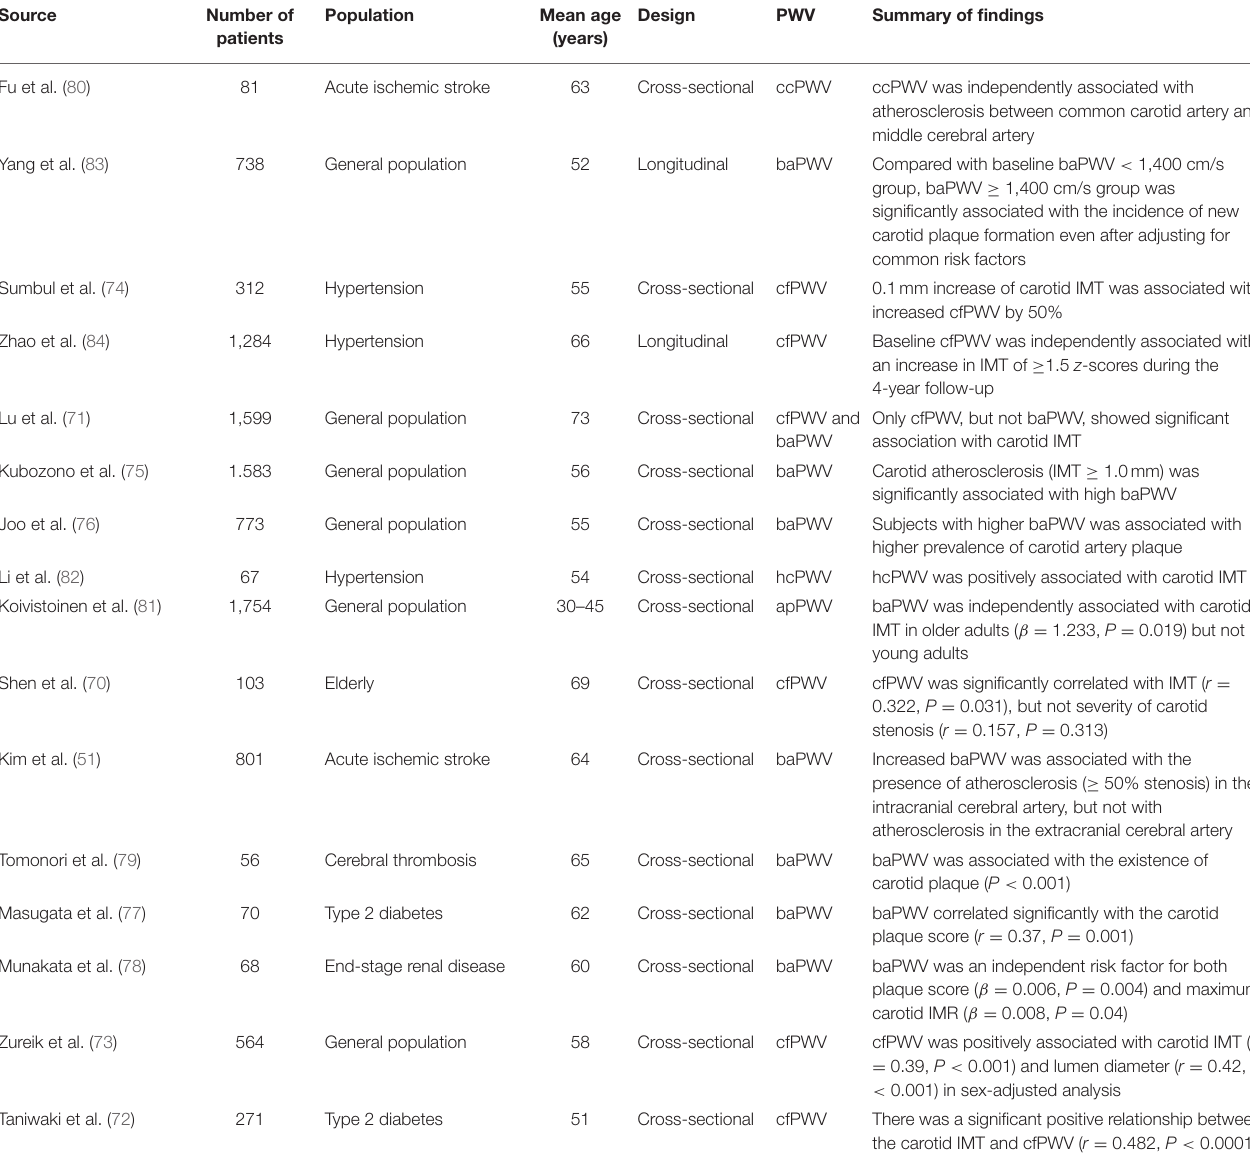
TABLE 3 | Summary of recent studies showing the association between pulse wave velocity and carotid artery